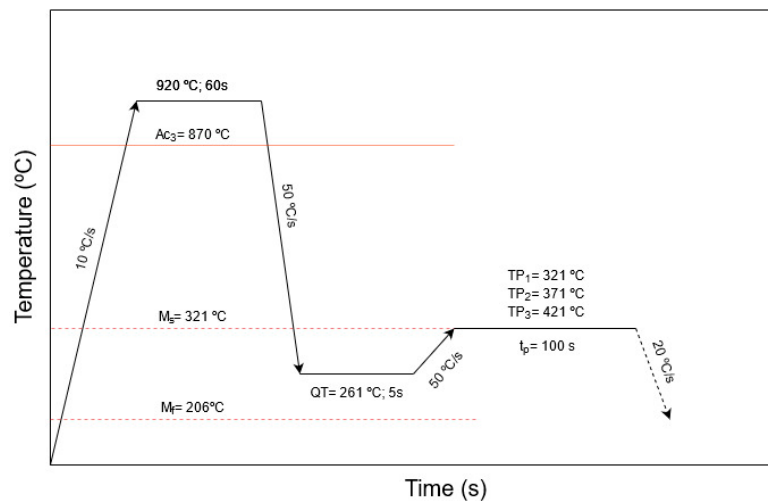
Figure 3. Schematic of the heat treatments applied to the present steel.